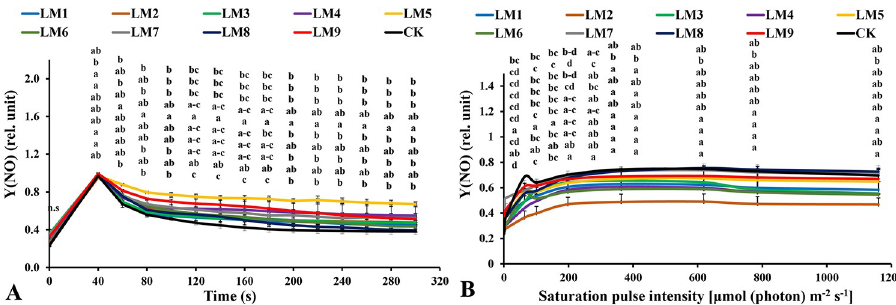
Fig 8. Effects of LED light modes on chlorophyll a fluorescence induction kinetics of the dark-acclimated (A) and RLC of the light-acclimated (B) of quantum yield of non-regulated energy dissipation in PSII Y(NO) in rocket leaves. The points are means ± SE of 4 replicates followed by the same letters meaning no different significantly according to the Duncan test (P � 0.05). Sort significance letters from top to bottom according to the treatments (ML1-CK). LM1 = A1:B1:C1, LM2 = A1:B2:C2, LM3 = A1:B3:C3, LM4 = A2:B1:C2, LM5 = A2:B2:C3, LM6 = A2:B3:C1, LM7 = A3:B1:C3, LM8 = A3:B2:C1, LM9 = A3:B3:C1, CK = White fluorescent light.